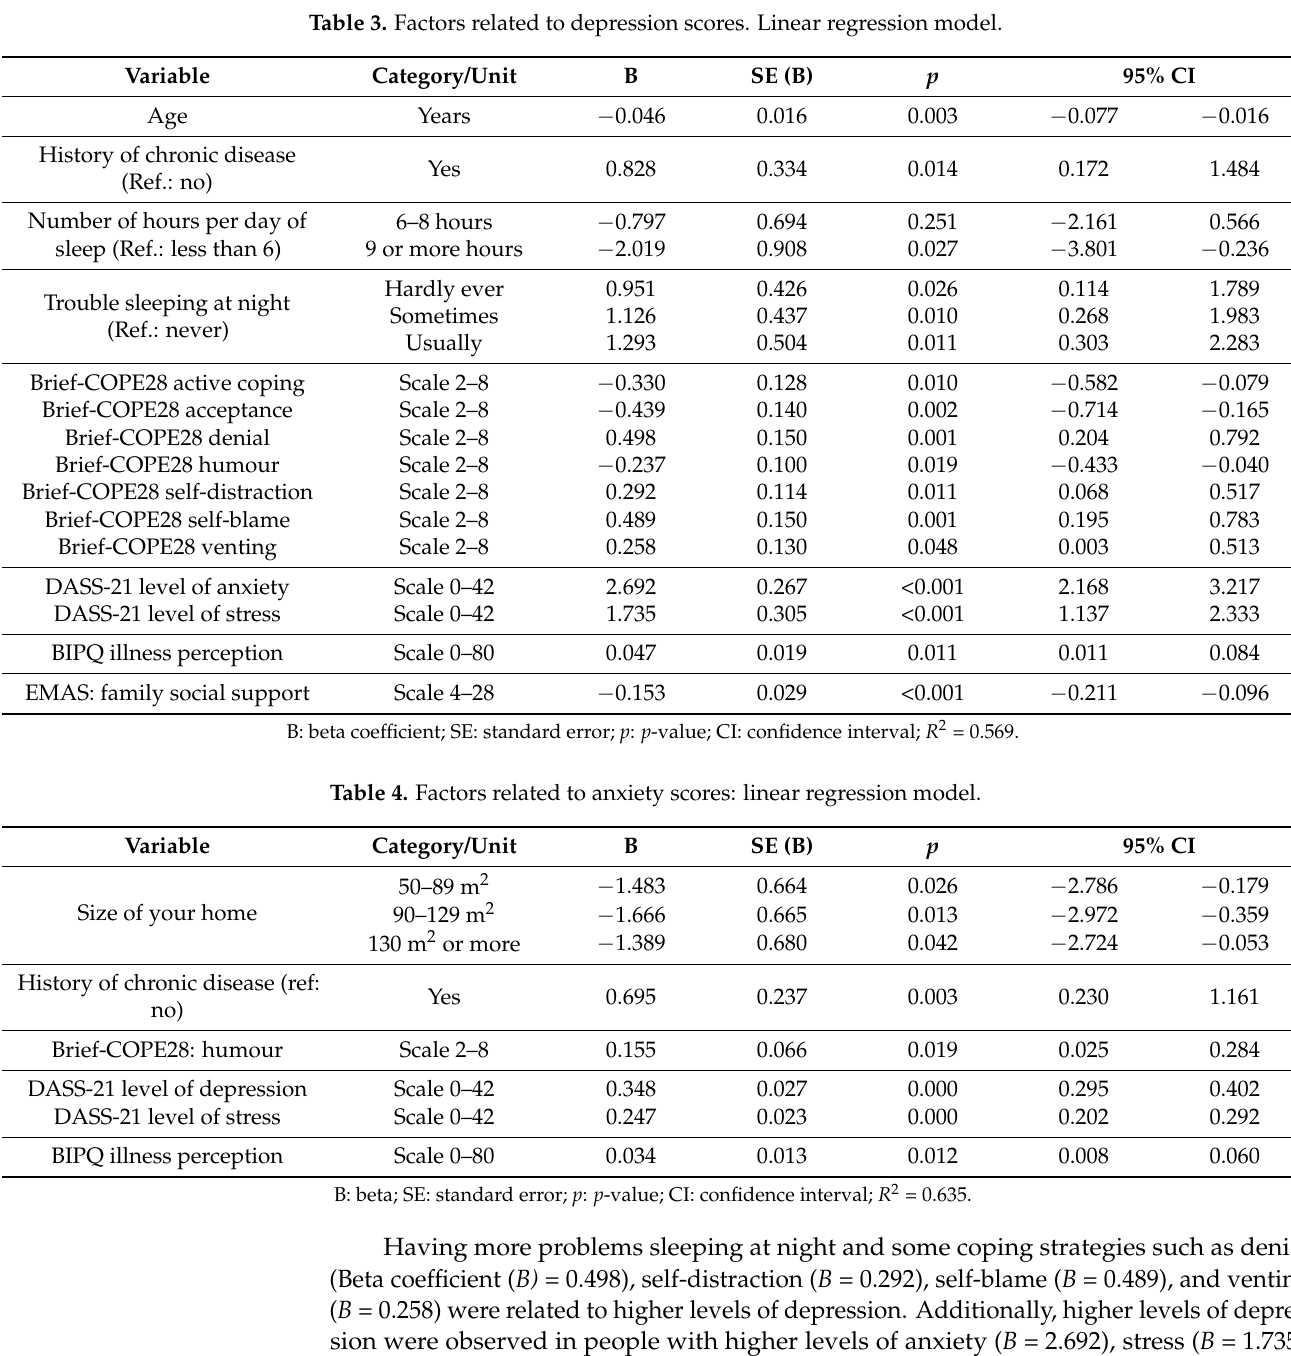
Having more problems sleeping at night and some coping strategies such as denial (Beta coefficient ( B) = 0.498), self-distraction ( B = 0.292), self-blame ( B = 0.489), and venting ( B = 0.258) were related to higher levels of depression. Additionally, higher levels of depres- sion were observed in people with higher levels of anxiety ( B = 2.692), stress ( B = 1.735), worse illness perception ( B = 0.047), and a history of chronic disease ( B = 0.828). In contrast, the levels of depression decreased by 0.046 points for each year of age, in people sleeping nine or more hours ( B = − 2.019) and with greater self-perceived family social support ( B = − 0.153) (Table